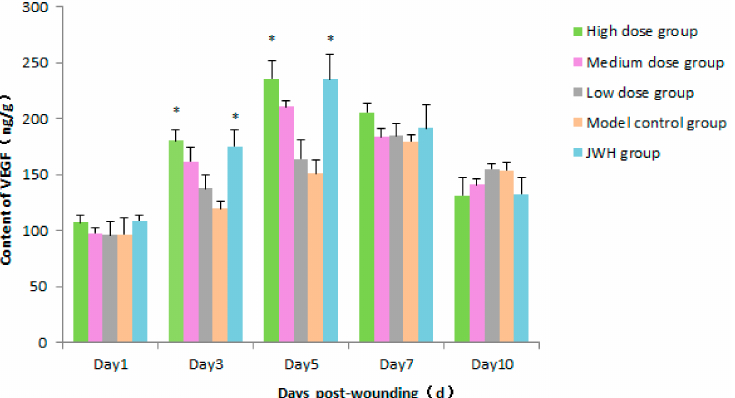
Figure 5. Effects of total flavonoids from B. balsamifera on vascular endothelial growth factor (VEGF) levels in wound tissues of rats. Values are expressed as mean ± SD ( n = 6) as compared to the control group, * p < 0.05.